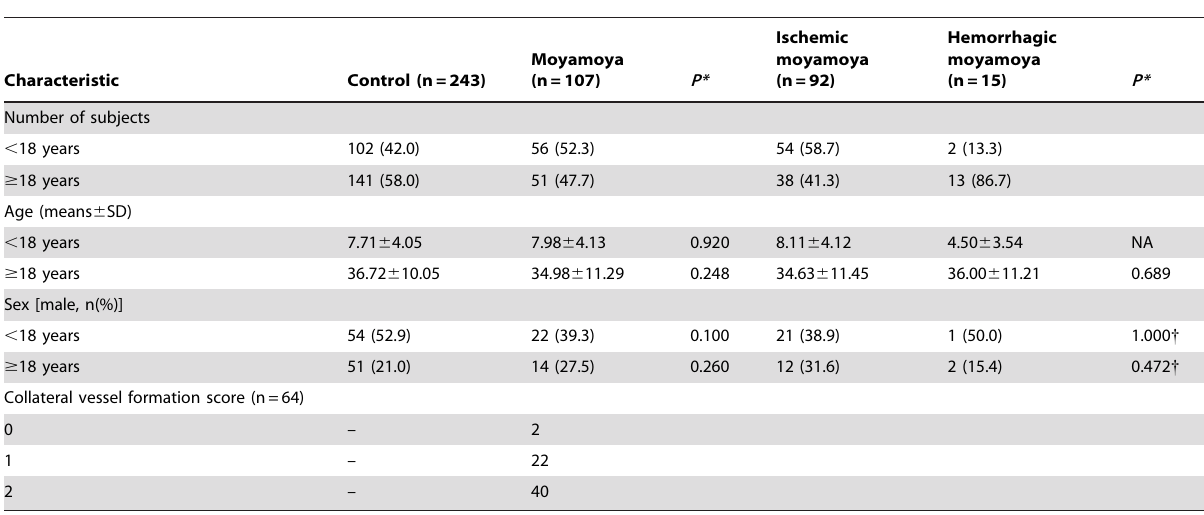
* P values were calculated using the Mann-Whitney test for continuous data and x 2 -test for categorical data. { Fisher’s exact test. NA; not applicable.